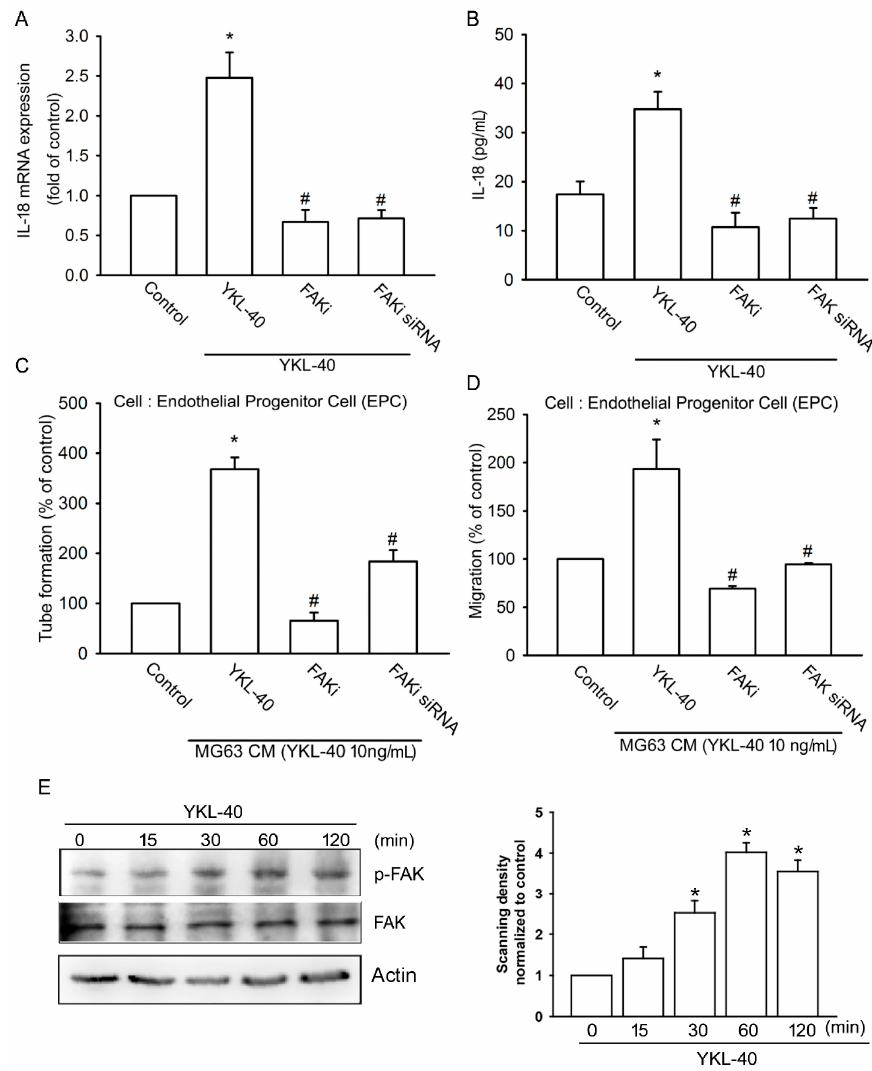
Figure 3. The focal adhesion kinase (FAK) signaling pathway regulates YKL-40-induced increases in IL-18 expression. ( A , B ) MG-63 cells were pretreated with a FAK inhibitor (10 μ M) or transfected with FAK siRNA for 24 h, then stimulated with YKL-40 for 24 h. IL-18 expression was examined using qPCR and ELISA assays ( n = 4 per group). ( C , D ) CM was collected and applied to EPCs. Capillary-like structure formation and cell migration of EPCs was examined by tube formation and Transwell assay ( n = 5 per group). ( E ) MG-63 cells were treated with YKL-40 for indicated time intervals, and FAK phosphorylation was examined by Western blotting. FAK phosphorylation in each independent experiment was quantified by densitometry in right panel ( n = 3 per group). Results are expressed as the mean ± S.E. * p < 0.05 compared with control. # p < 0.05 compared with the YKL-40-treated group.